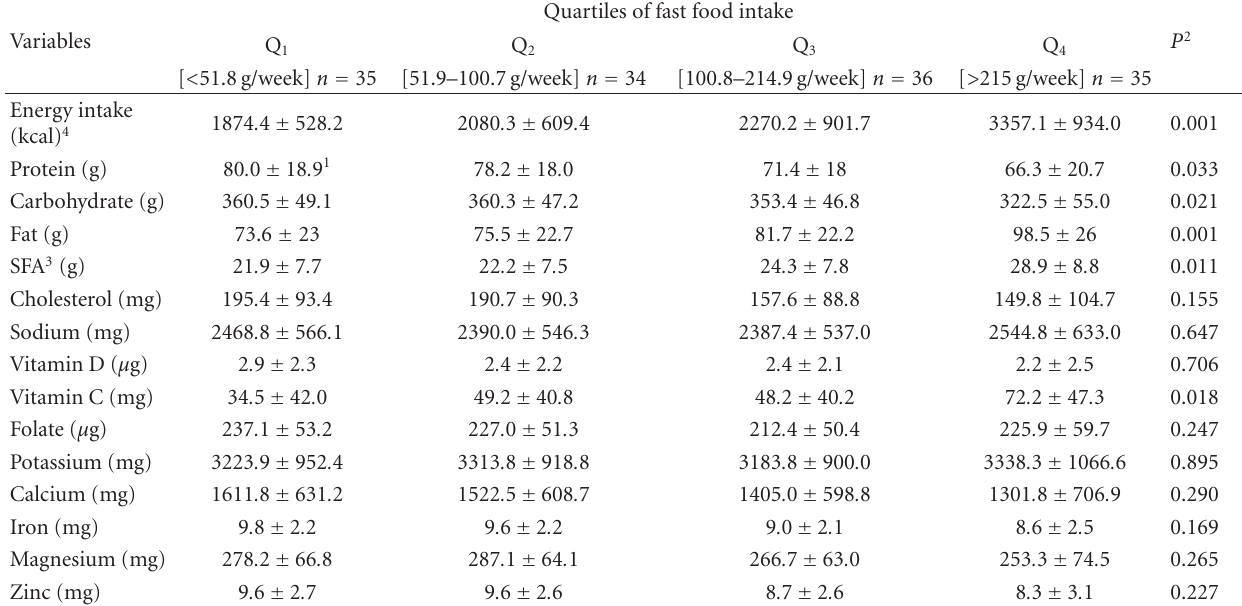
Table 2: Energy-adjusted distribution of nutrient intake across quartiles of fast food consumption.